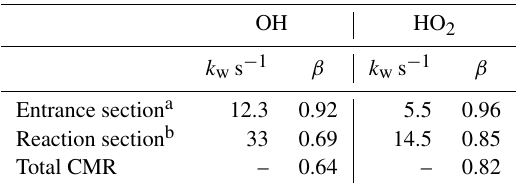
Table 4. Transmission and wall loss rate coefficients for OH and HO 2 in the chemical modulation reactor (1 / 8in. injectors) when nitrogen is